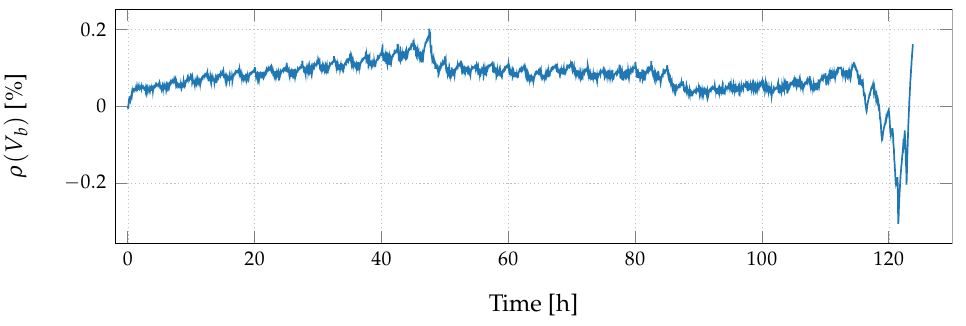
Figure 15. Relative error of the model with dynamic ζ a on the random load test.